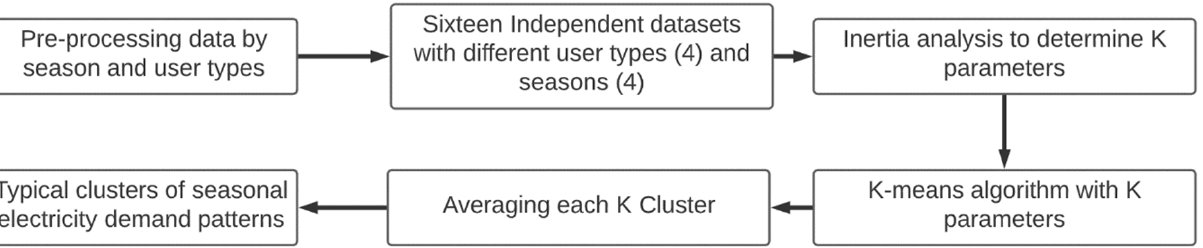
Figure 6. Establishing typical seasonal SA1 demand pro fi les with K -means.